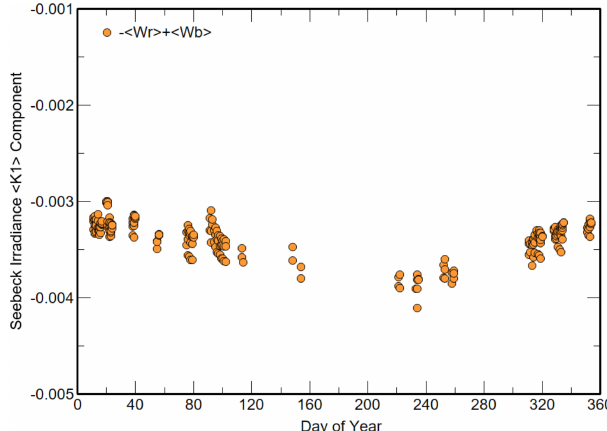
Figure 10. The difference in the receiver irradiance slope <A r > and the slope by assuming the Seebeck coefficient is 0 <A b > when deriving <K 1 > from the linear LSQ